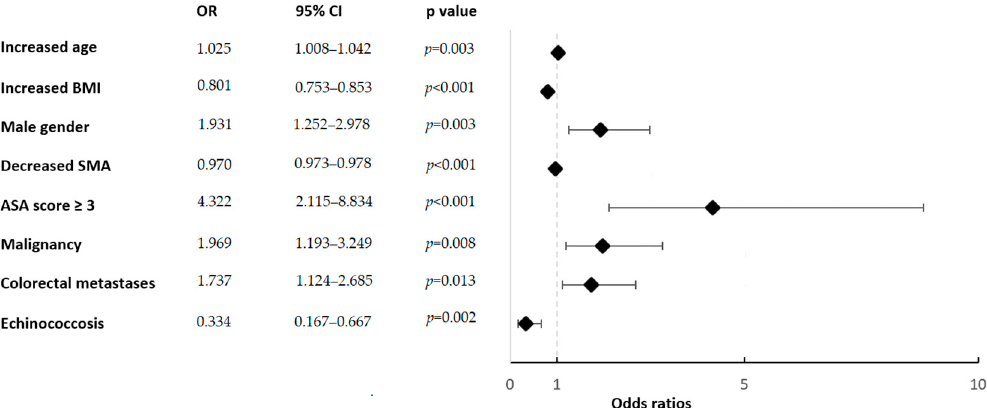
Figure 2. Multivariable analysis results indicate risk factors for sarcopenia. The analysis included all factors identified as significant in univariable analysis ( p < 0.05). OR = odds ratio; BMI = body mass index; SMA = skeletal muscle area, ASA = American Society of Anesthesiologists. Dotted vertical line: null effect (OR = 1).The overall complication rates were 46.2% ( n = 98) in the sarcopenia group vs. 48.3% ( n = 69) in the group without sarcopenia ( p = 0.745). A total of 24 patients (11.3%) in the sarcopenia group had major complications vs. 16 patients (11.3%) in the group without sarcope- nia ( p = 1.00, Table 2). For complications specific to liver resection, the groups displayed no signifi- cant difference in the rate of bile leakage or postoperative liver failure. There was no 30-day mortal- ity for the entire cohort. None of the sarcopenia indices was a predictive factor of major complica- cholangiocarcinoma (OR 2.762, 95% CI 1.218–6.264, p = 0.015). A subgroup analysis for patients with